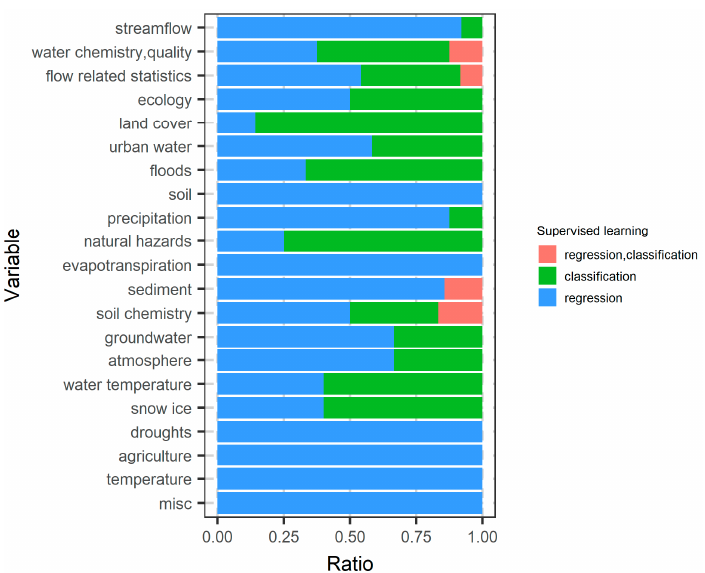
Figure 14. Ratio of supervised learning tasks conditioned on the examined variable. The respective numbers of papers are shown in Figure 7.